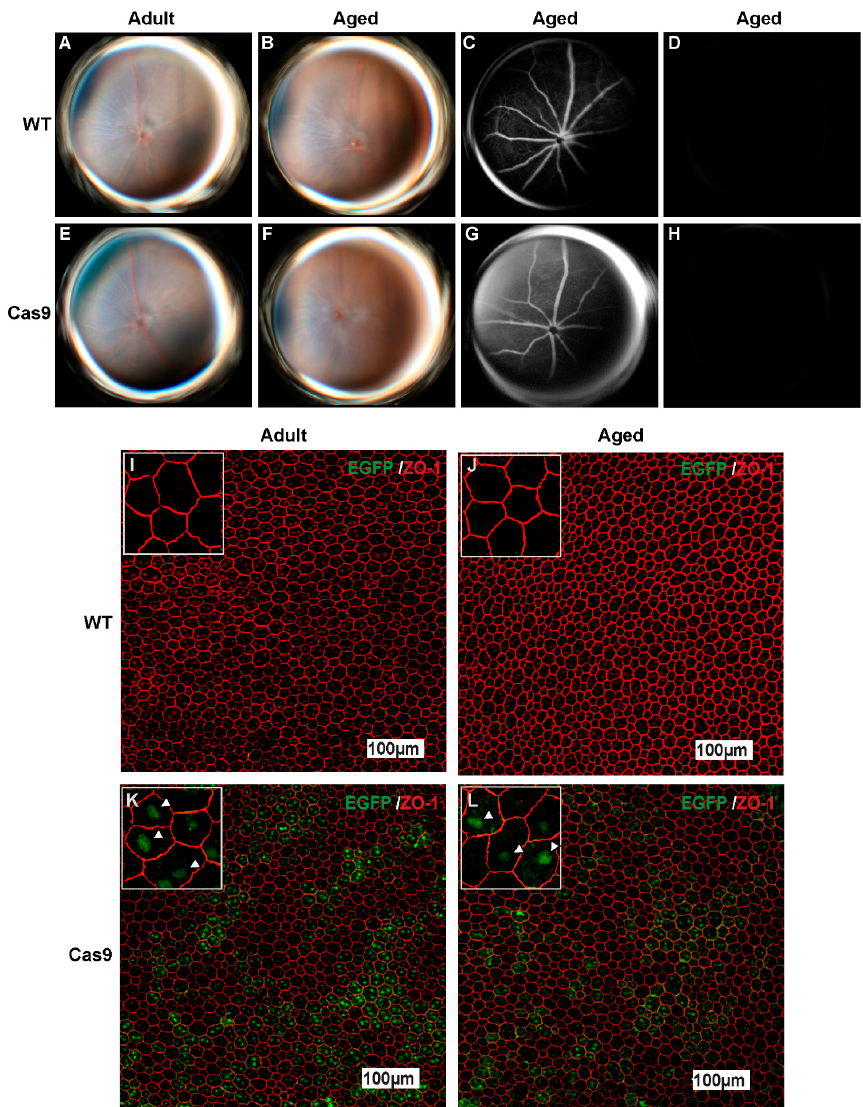
Figure 2. Phenotypic comparison between wildtype and Cas9 mouse eyes. ( A , E ) Representative fundus photographs of adult Cas9 mice ( E ) appear to be normal and healthy and comparable to those of the adult WT mice ( A ). ( B , F ) Representative fundus photographs of aged Cas9 mice ( F ) show normal fundus and are comparable to those of the similarly aged WT mice ( B ). ( C , G ) Fluorescein angiography of fundus showed no vascular defects in aged Cas9 and WT mice. ( D , H ) Fundus autofluorescence imaging showed absence of autofluorescence in both aged Cas9 and WT mice. ( I , J ) RPE morphology was visualized by immunostaining for ZO-1 (red) on R PE/choroid flat mounts of adult and aged WT mice. ( K , L ) RPE of adult Cas9 mice and age-matched controls showed typical hexagon pattern with ZO-1 staining (red) and nuclear-localized signal from EGFP (green).White arrowheads in images from the inset in K and L indicate nuclear-localized EGFP. Scale bar: 100 µ